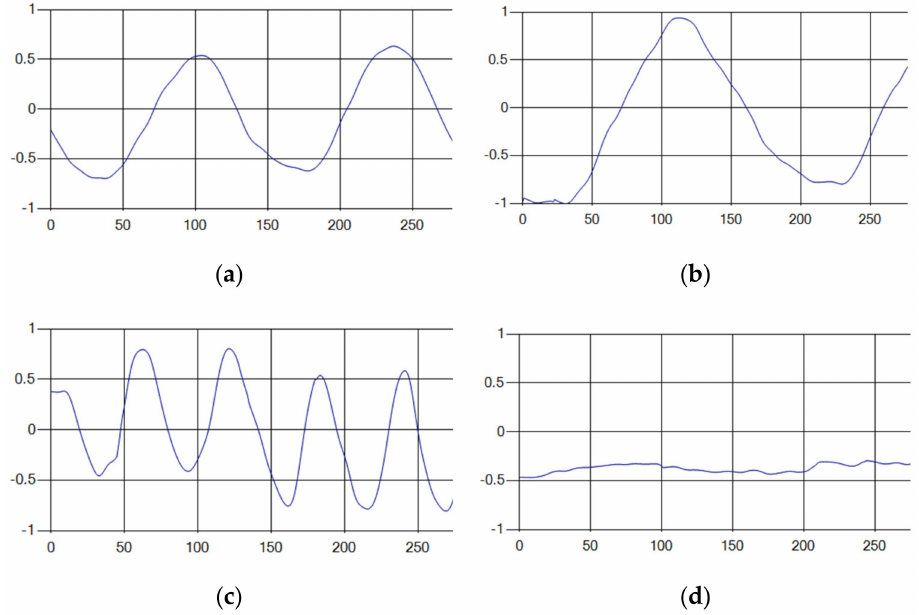
Figure 1. Four respiratory signal patterns measured by UWB sensor. ( a ) Eupnea. ( b ) Bradypnea. ( c ) Tachypnea. ( d )